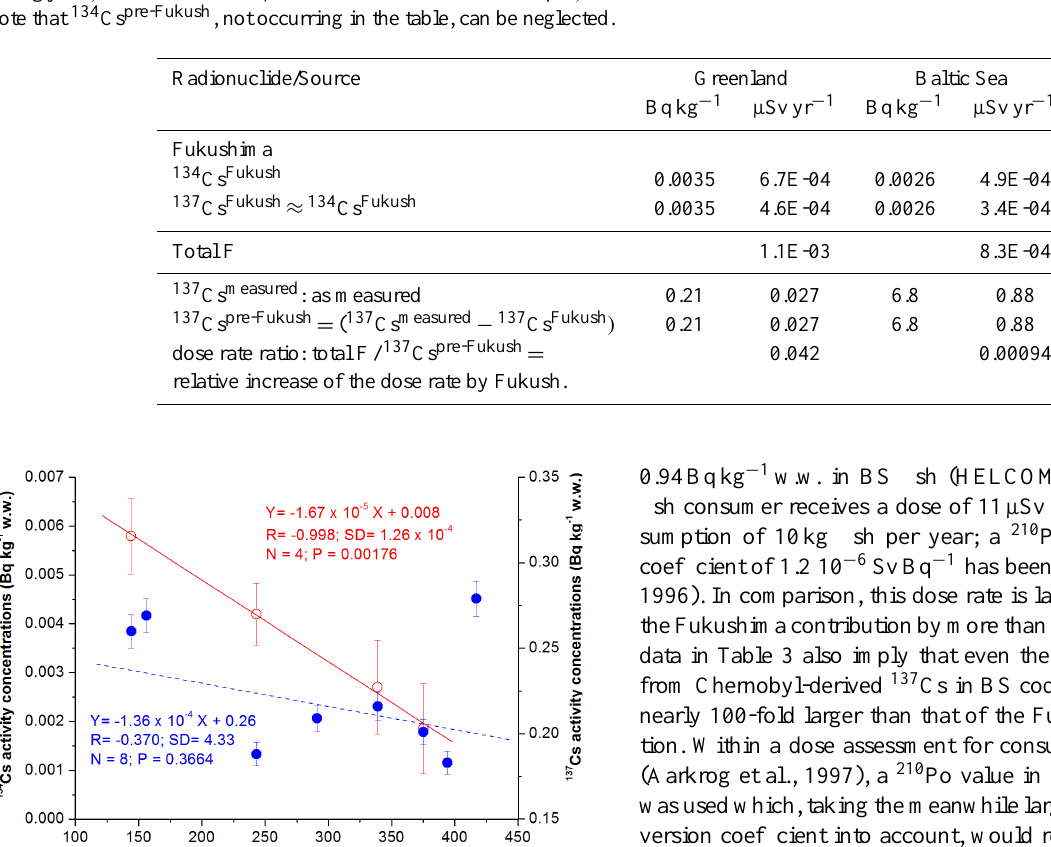
Table 3. Average activity concentrations (Bqkg − 1 ) and effective dose rate (µSvyr − 1 ) contributions to human individuals from consumption